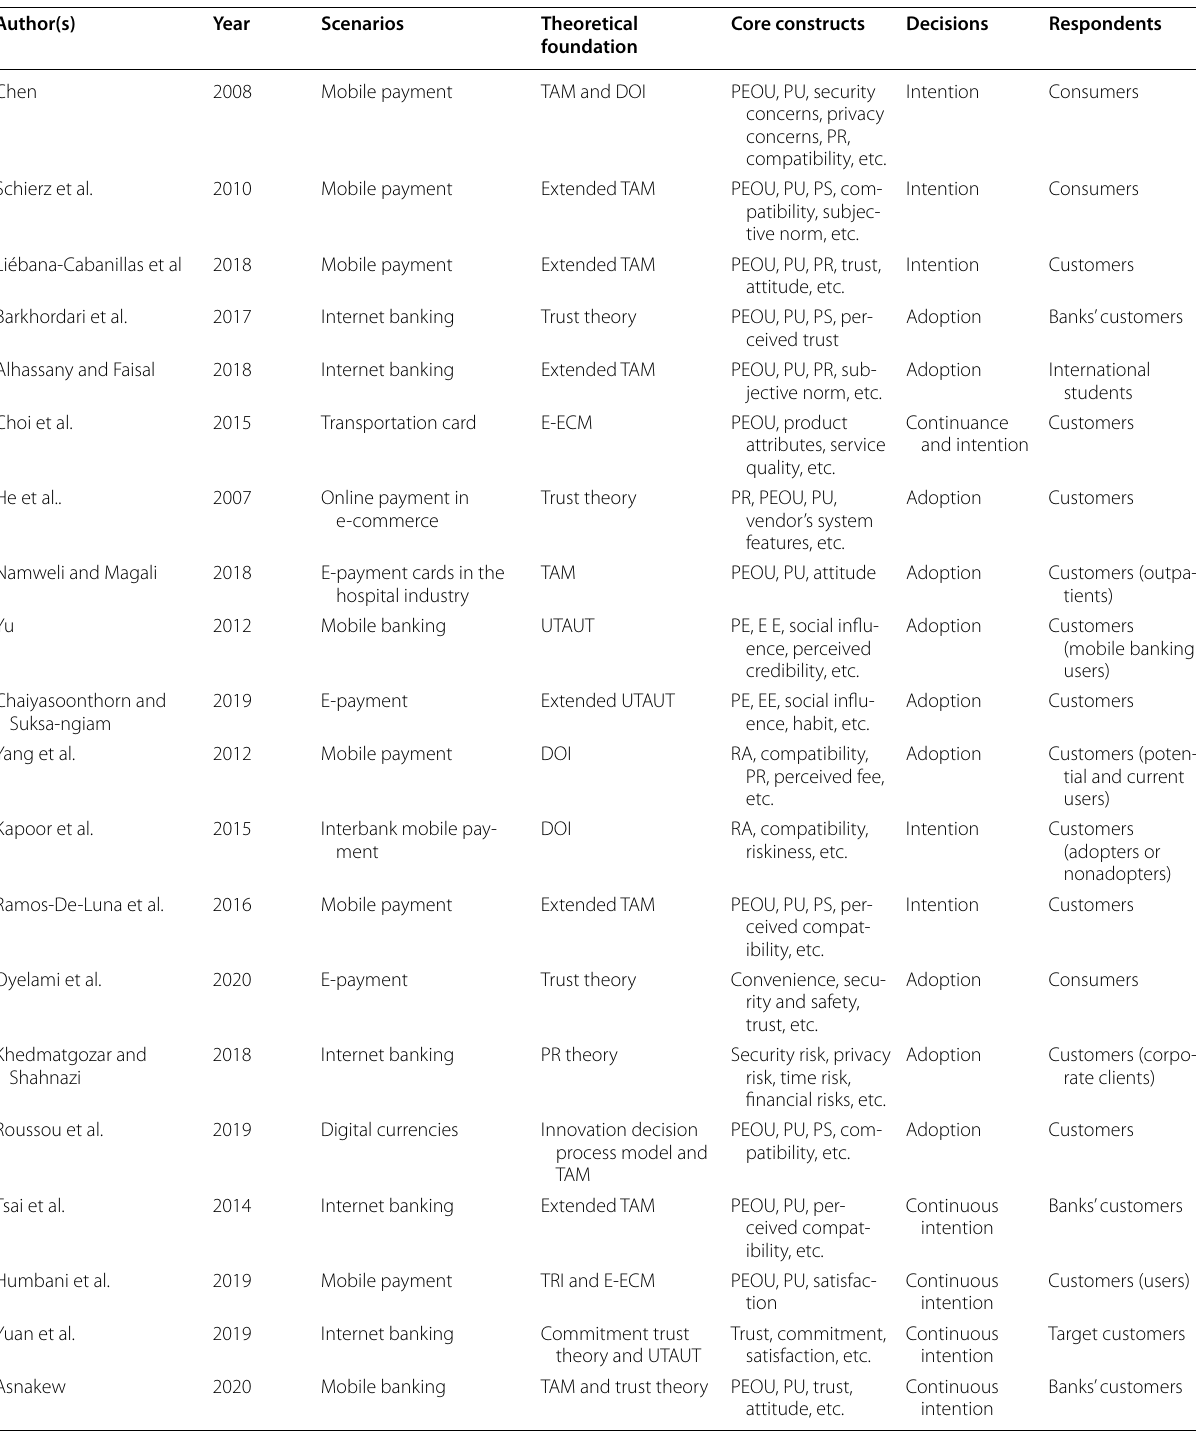
Table 1 The overview of previous research